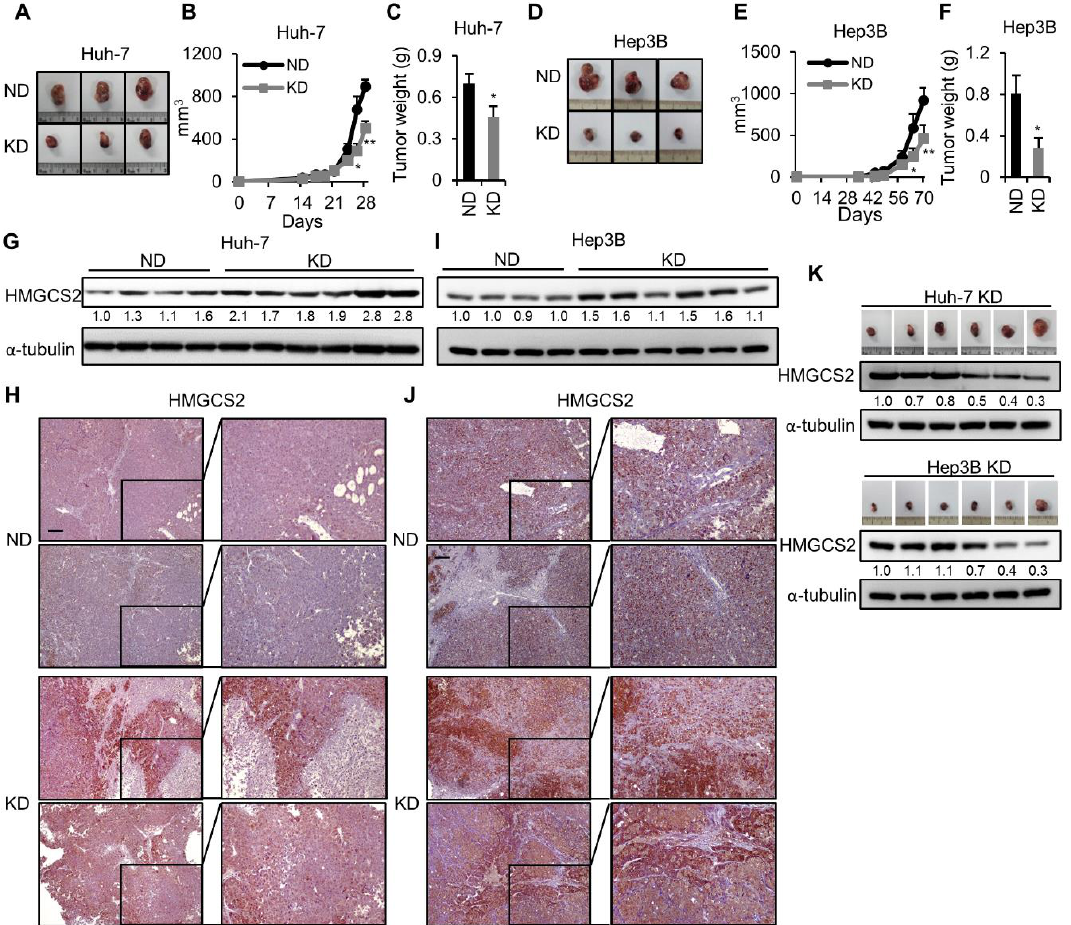
Figure 1. Mice fed a KD inhibited tumor growth, which was accompanied by increased HMGCS2 expression. Mice were fed an ND or KD two weeks before subcutaneous implantation of 5 × 10 6 Huh-7 and Hep3B cells. n = 6 / group. ( A , D ) Representative images of tumors from either feeding the normal diet (ND) or feeding the ketogenic diet (KD). ( B , E ) The tumor growth rate and ( C , F ) the tumor weight of each group. ( G , I ) Western blot analyses of HMGCS2 using protein lysates derived from tumors HMGCS2 IHC-stained sections of tumors from each treatment group. Scale bars: 0.1 mm. ( K ) Paired HMGCS2 western blotting images and tumor mass among the KD groups. The quantification of